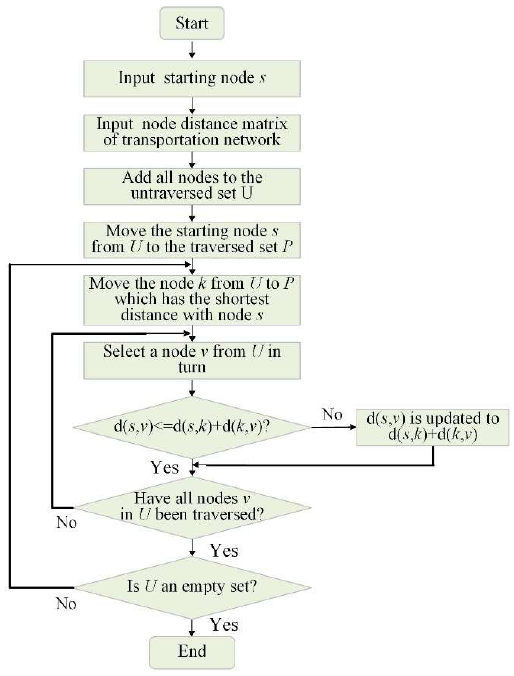
Figure 4. Flowchart of Dijkstra algorithm.